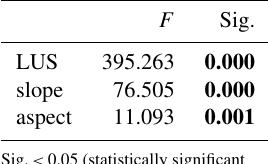
Table 4. MANOVA results showing the significance of the impact of land use, slope, and aspect for SOC ( n = 1440).